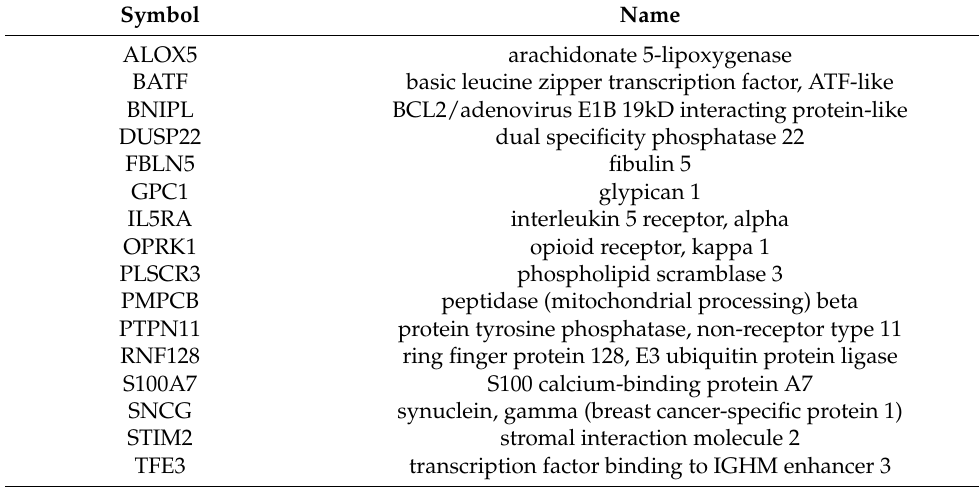
Table 1. Novel candidates identified in the study; list of 16 novel genes found to be significant in both HPRD and BioGRID